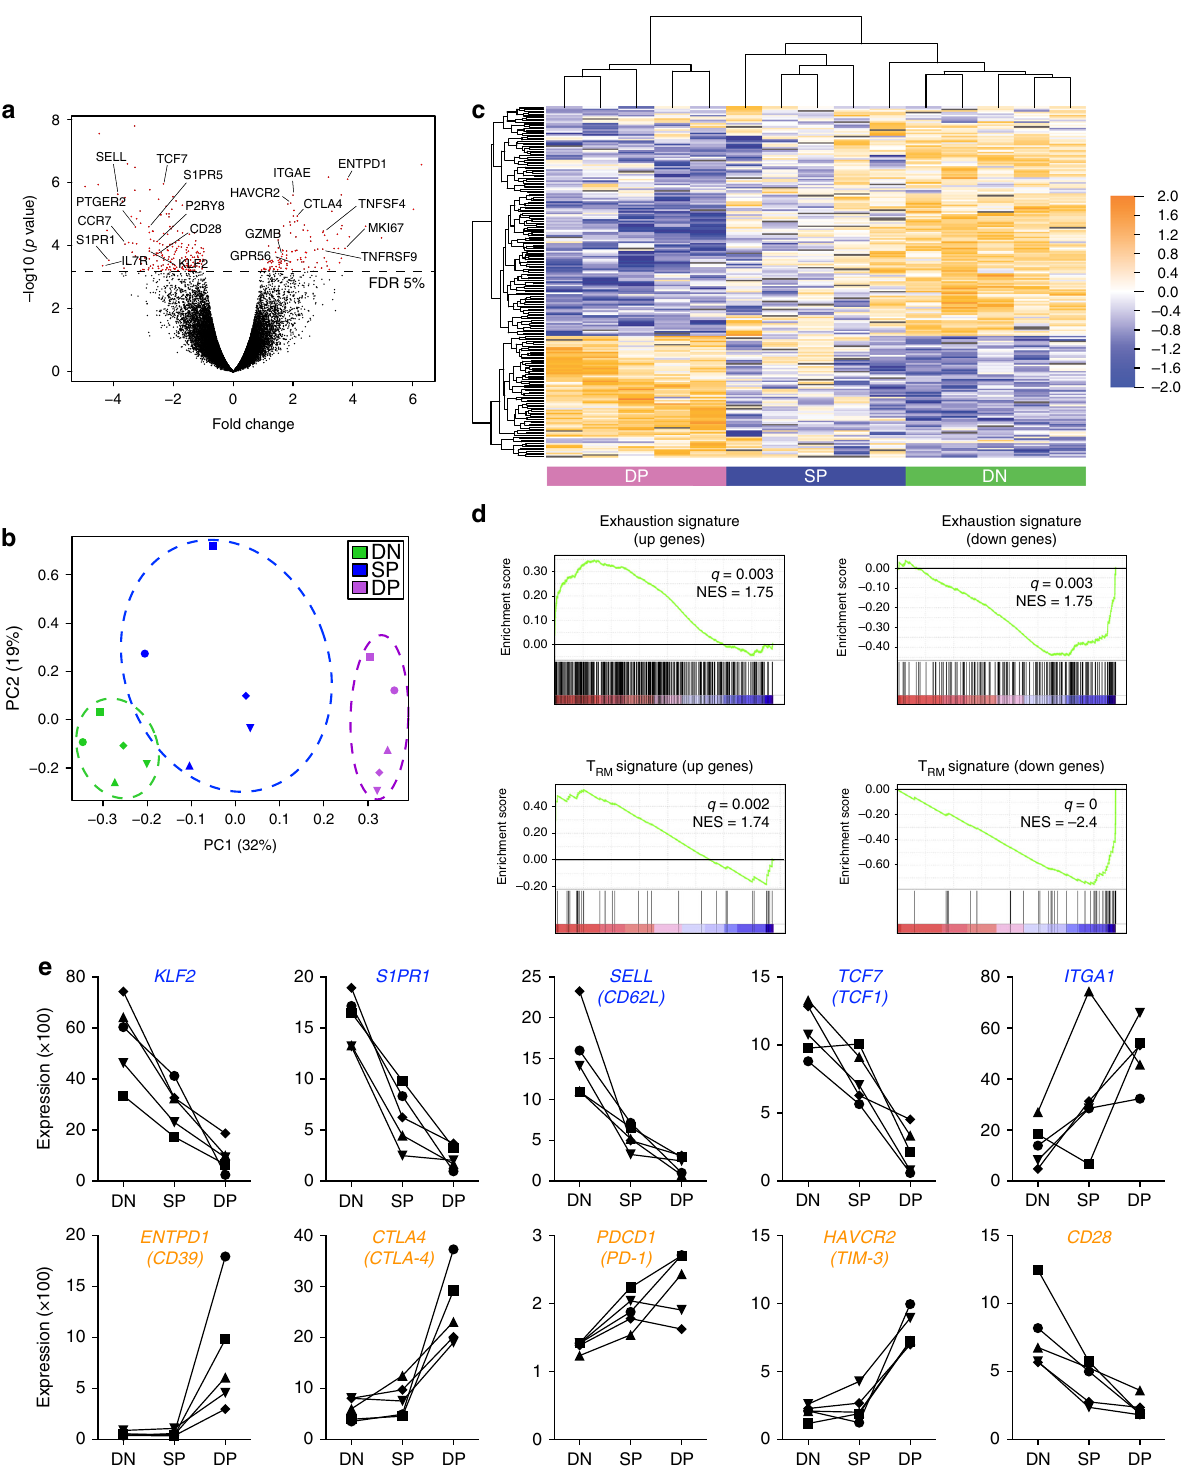
Fig. 2 Gene-expression analysis of DP CD8 TILs reveals an exhausted pro fi le and a gene signature reminiscent of T RM cells. a Volcano plot showing differential gene expression of the DP vs. DN CD8 T-cell subsets (log2-transformed). The dashed line delineates the differentially expressed genes (red dots) when using a false-discovery rate (FDR) <5%. b PCA of the 219 differentially expressed genes between the DP and DN CD8 TILs with a FDR <5% among all three subsets. Dots indicate samples of the three different populations from a total of fi ve patients. PCA 1 and 2 represents the largest source of variation, combined accounting for 51%. Each symbol represents one patient. c Unsupervised clustering of the 219 differentially expressed genes between DP and DN CD8 on all three subsets of CD8 TIL from fi ve patients. Blue color indicates downregulated genes, orange indicates upregulated genes. d GSEA of “ T-cell exhaustion ” and “ T RM ” gene sets in the transcriptome of DP CD8 vs. that of DN CD8 TILs, presented as the normalized enrichment score (NES). e Examples of differentially expressed genes between DP CD8 and DN CD8 TILs present in the “ T RM ” (blue) or the “ T-cell exhaustion ” (orange) gene sets. Each symbol/line represents one patient, which is connected by a